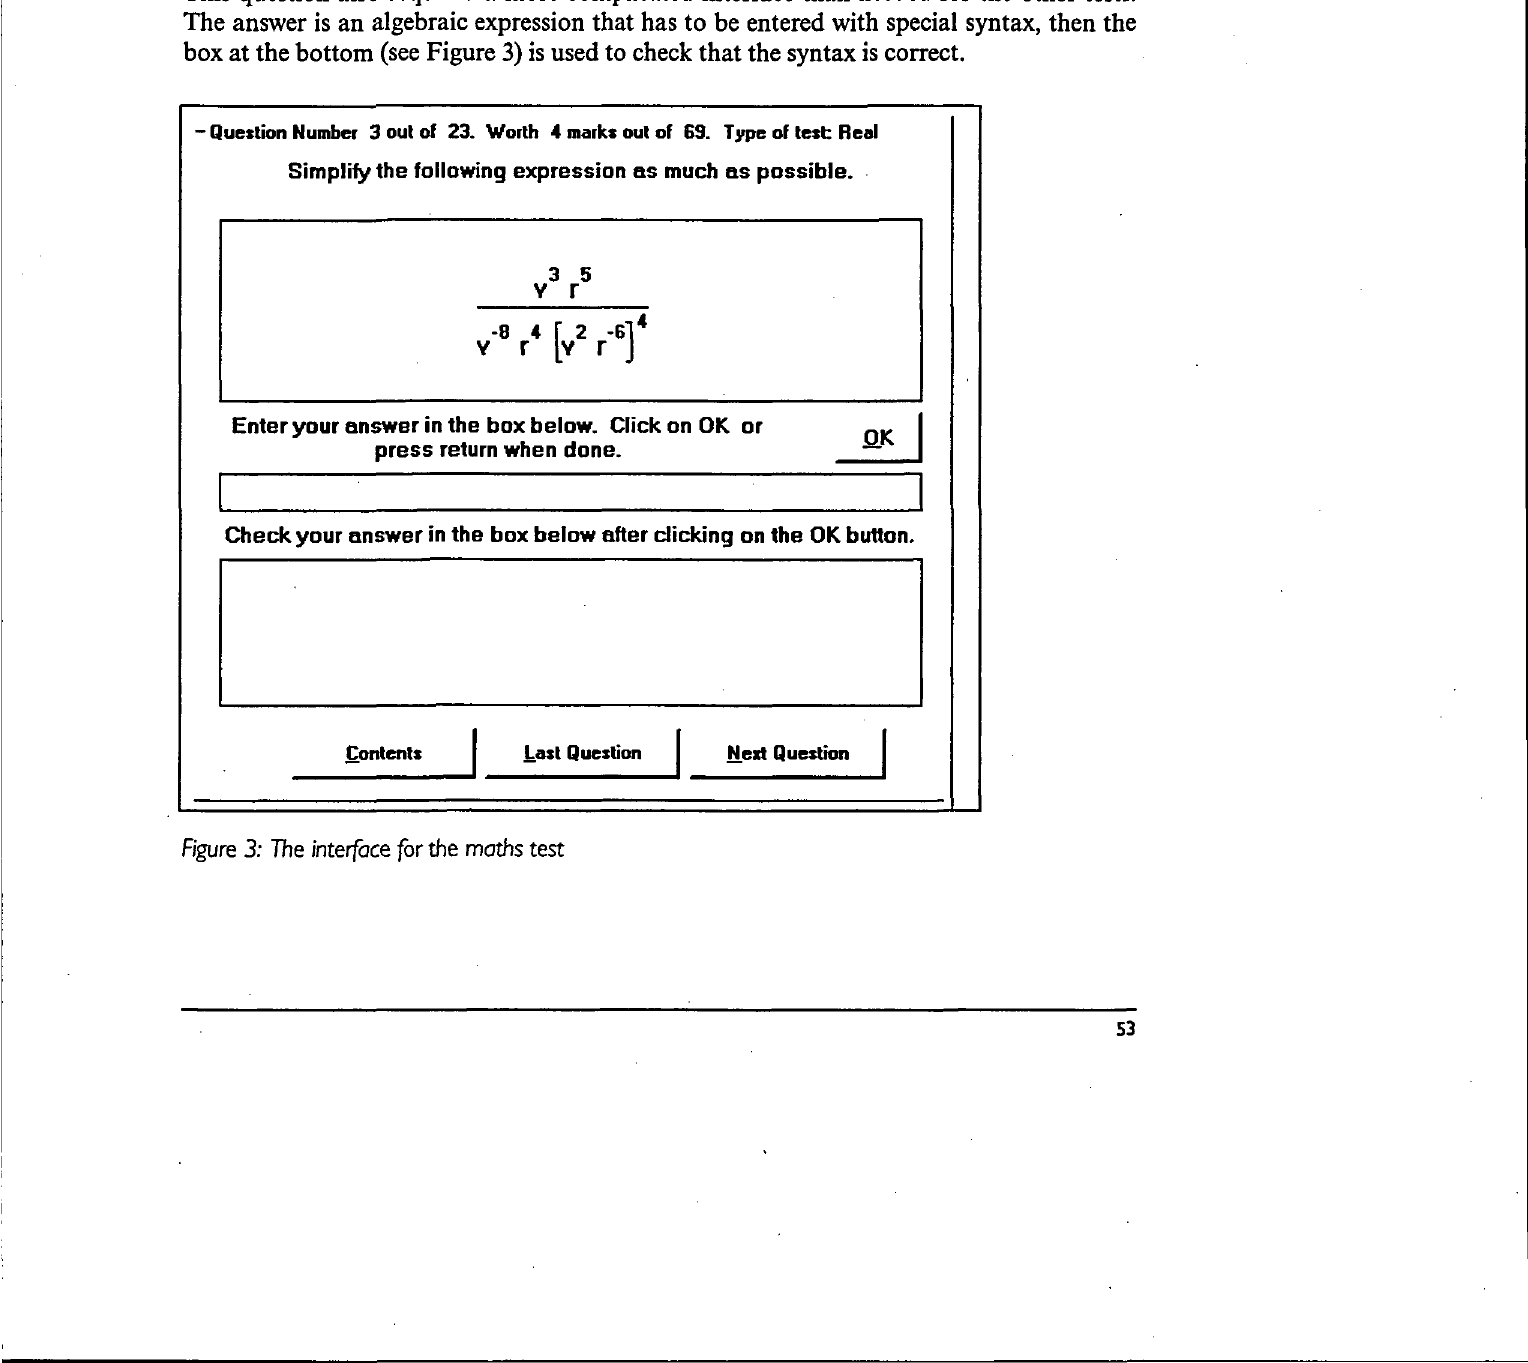
Figure 3: The interface for the maths